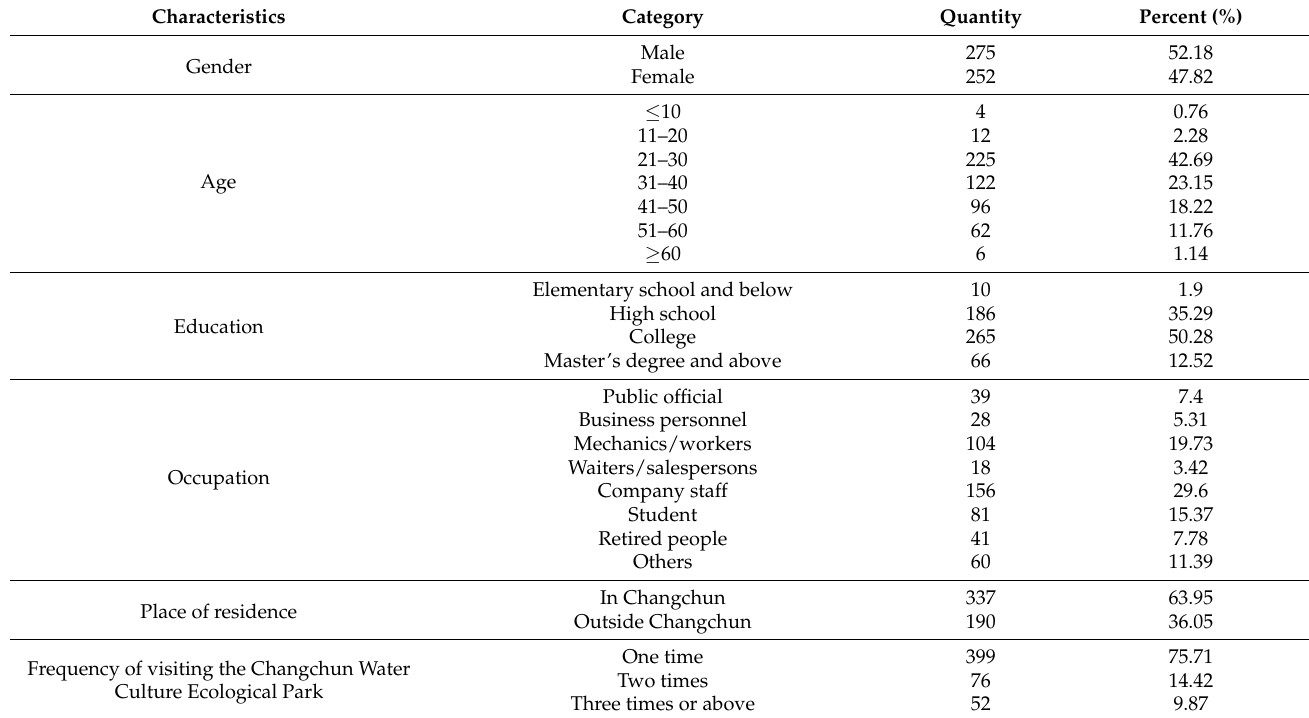
Table 5. Demographic data of the visitors of Changchun Water Culture Ecological Park interviewed for our